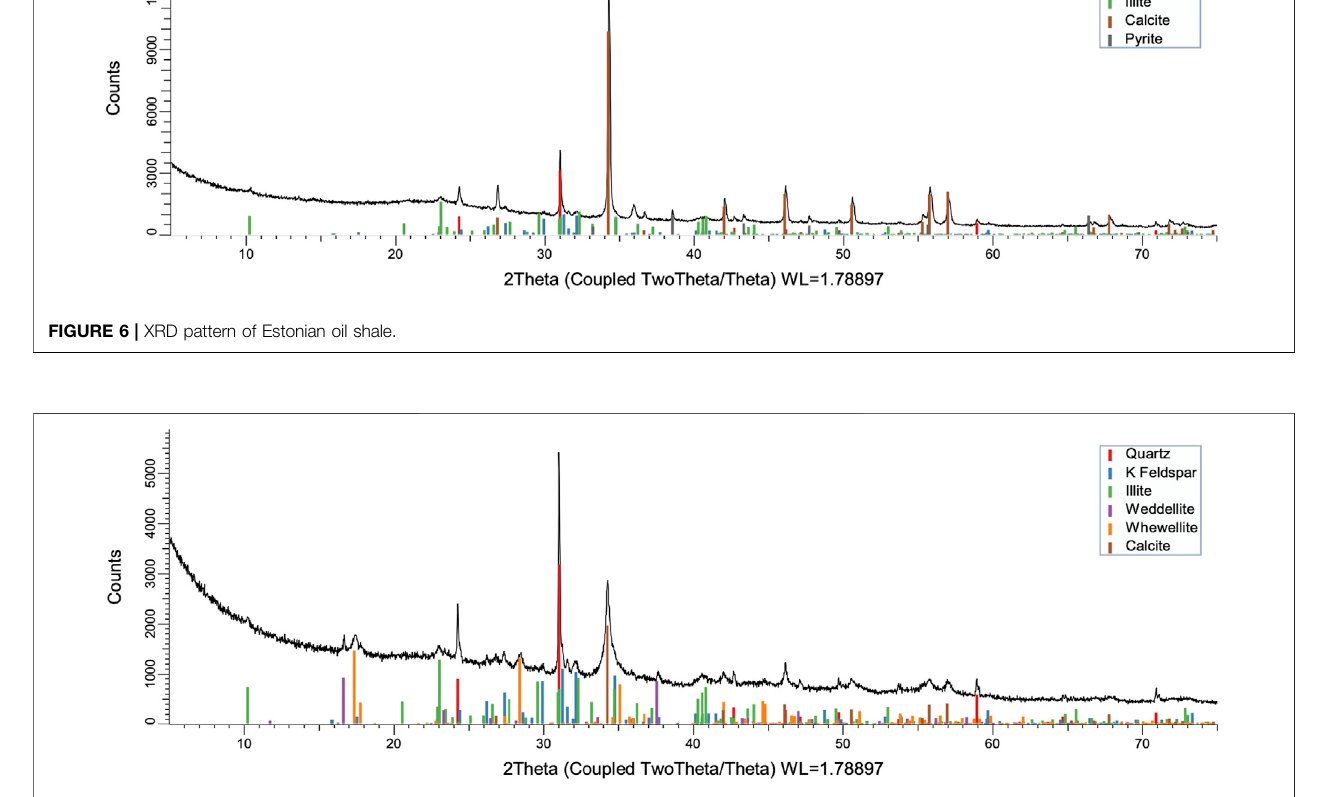
FIGURE 7 | XRD pattern of oxidation residue at 80 ° C and 1